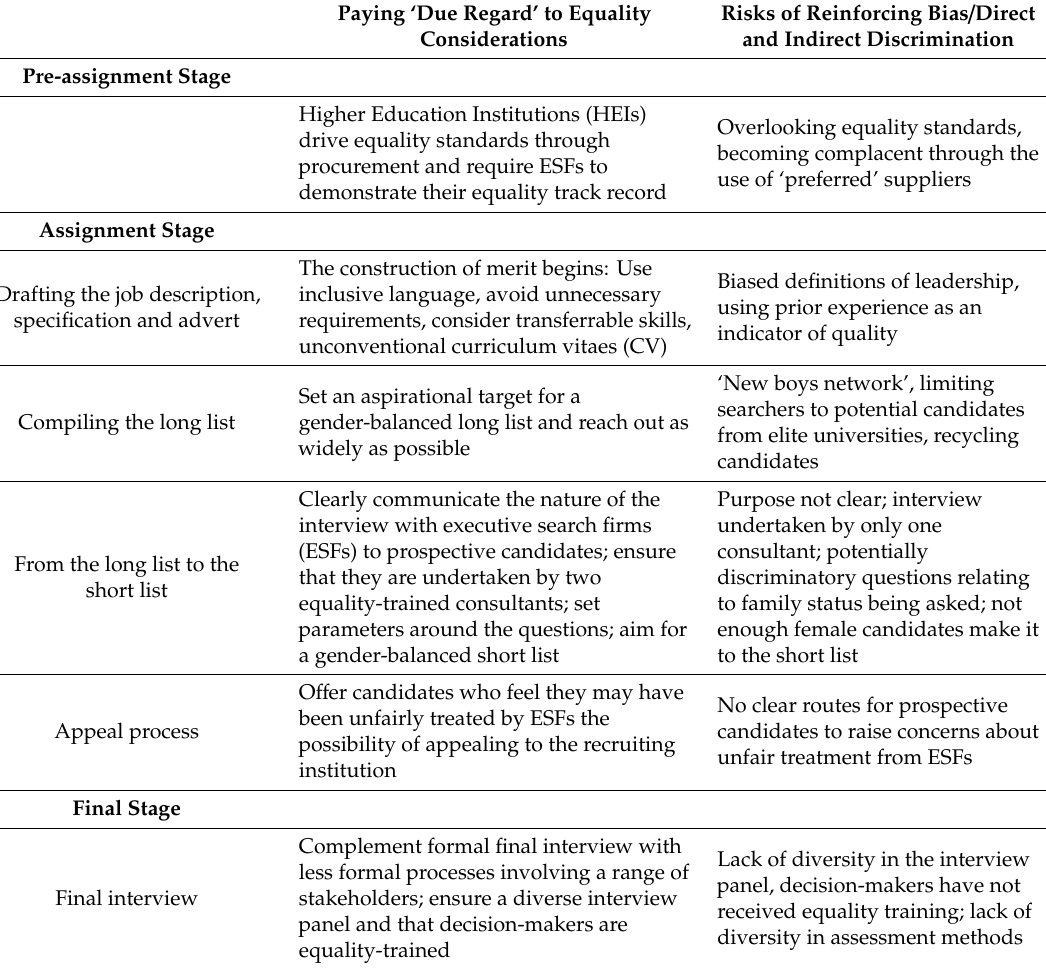
Table 1. Equality ‘due diligence’